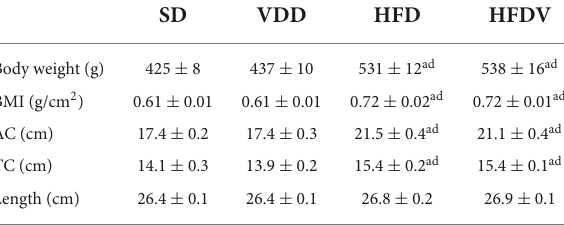
TABLE 1 Anthropometric parameters evaluated after the 90-day protocol in rats submitted to renal ischemia-reperfusion insult on day